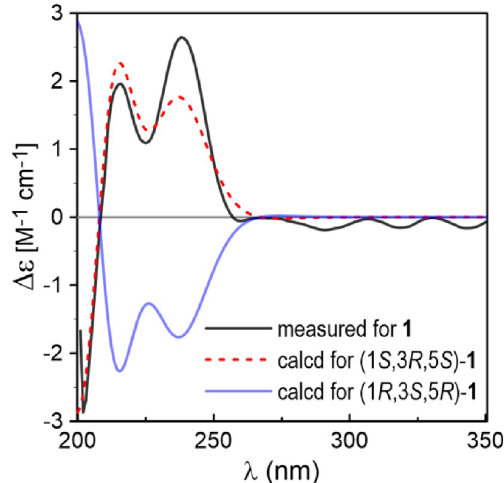
Fig. 3 Comparison between the measured and PBE0/Def2-SVP/PCM (MeOH) calculated ECD spectra of 1 (σ = 0.34, shift = + 11 nm)